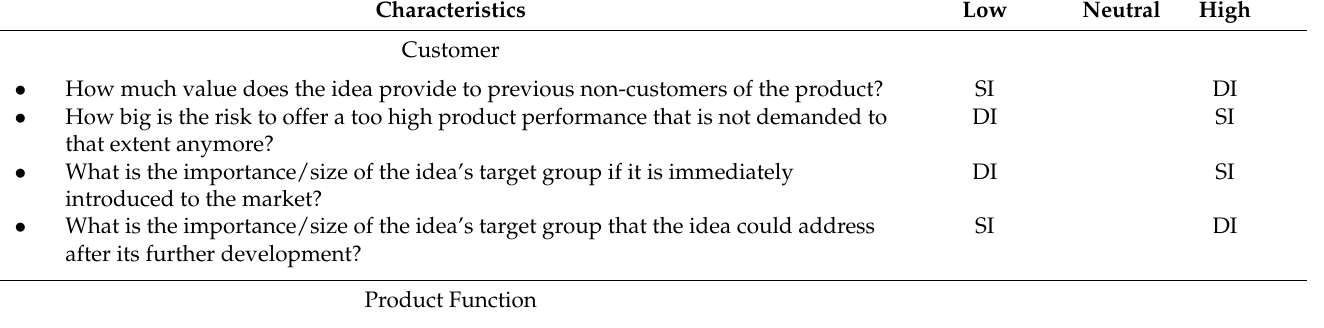
Table 2. Criteria to analyze the disruptiveness of product ideas, based on [1,2,5,7,13,15,16,18,32]. Characteristics